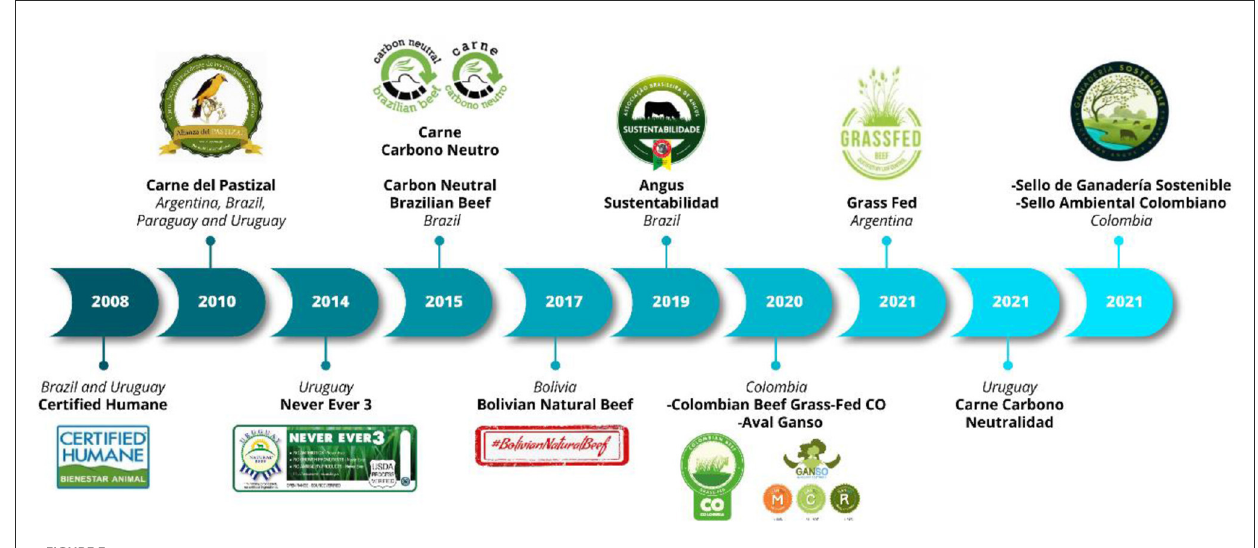
FIGURE3 Historical development of sustainability labels in Latin America.